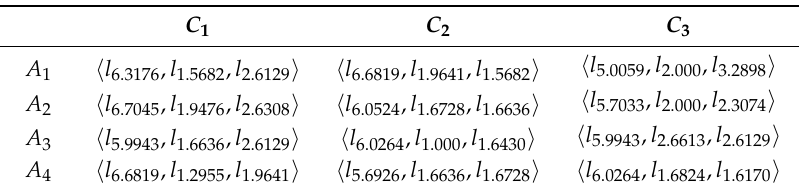
Table 5. The integrated matrix R